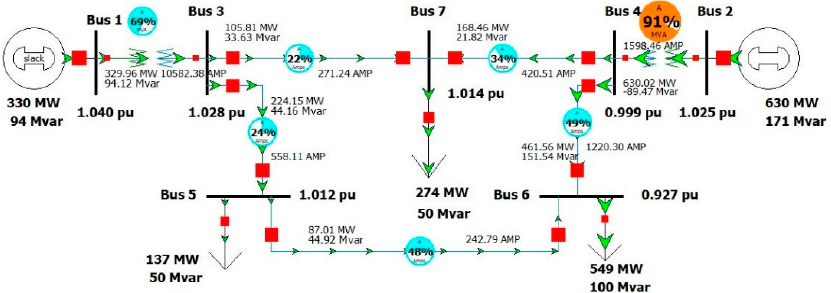
Figure 22. Final power flow scenario according to assigned injection group and contingency.